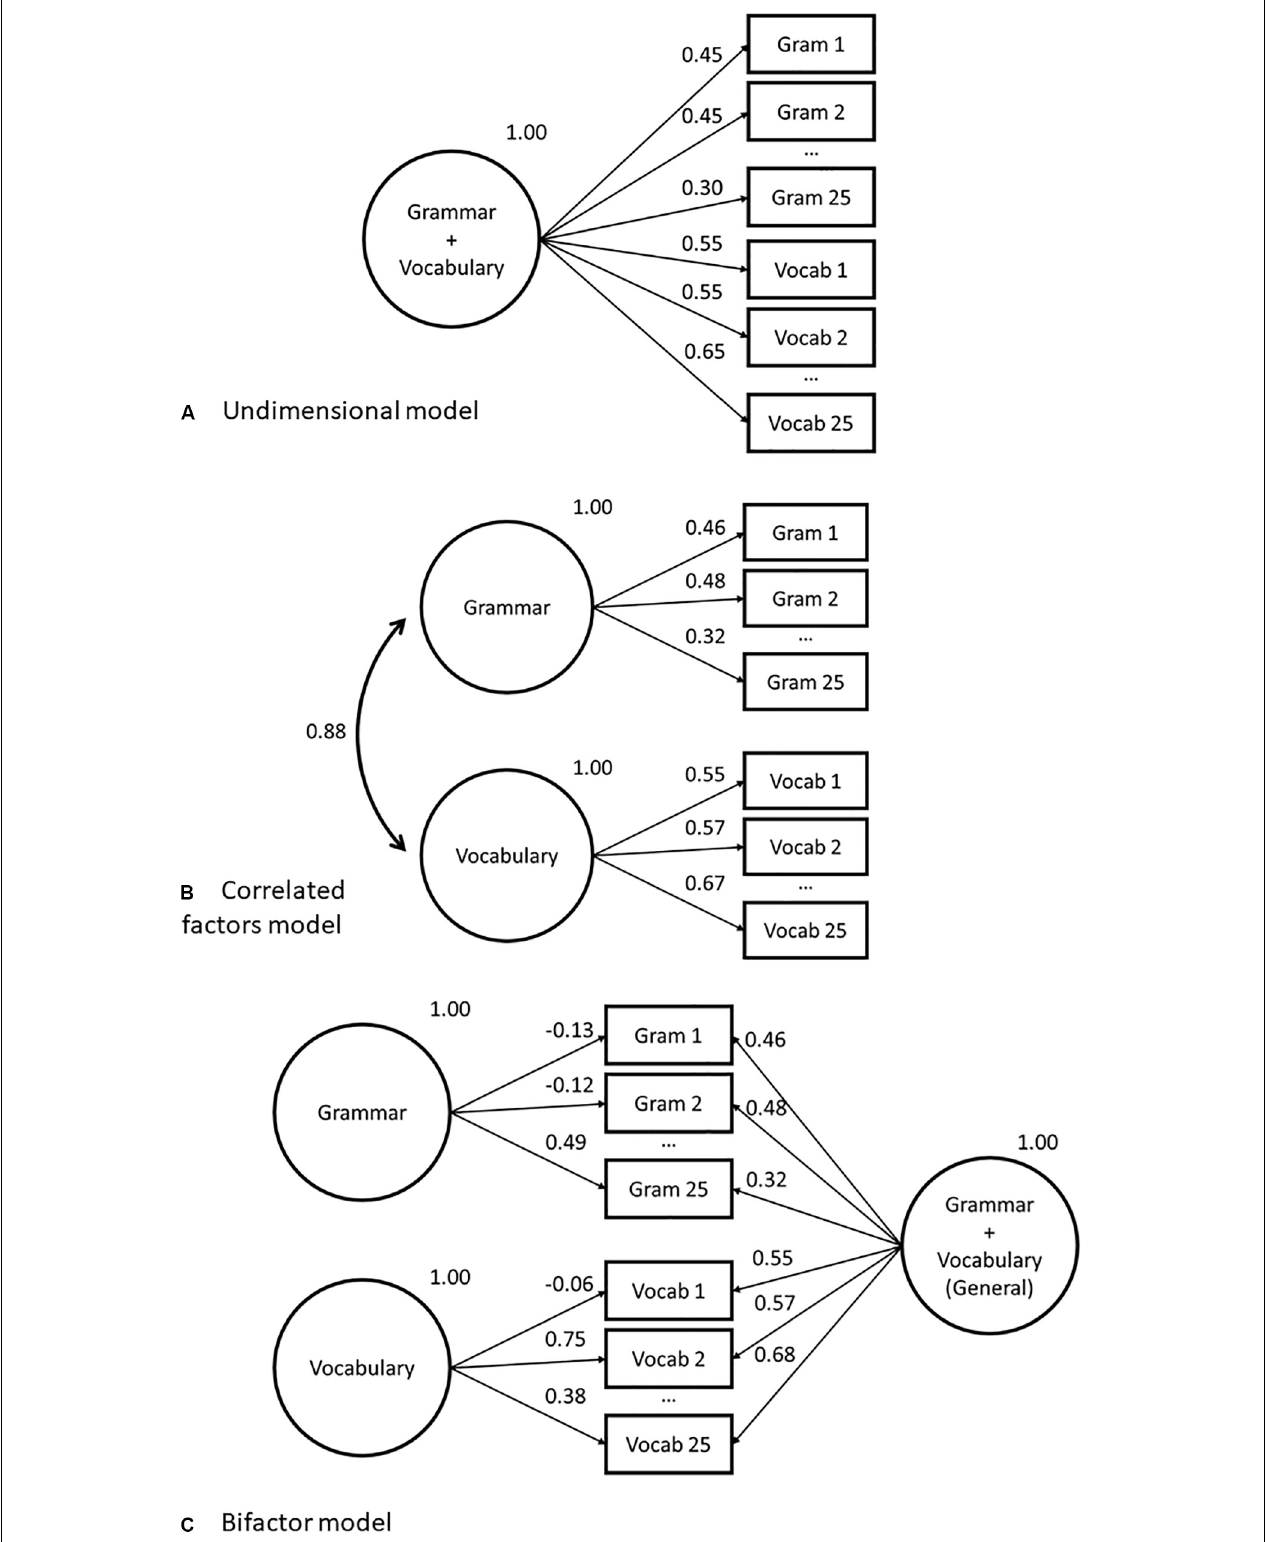
FIGURE 1 | Abbreviated factor loading diagrams for confirmatory factor analysis (CFA) models fit to grammar and vocabulary dataset in study 1. Models as follows: (A) Unidimensional; (B) Correlated factors; (C) Bifactor.